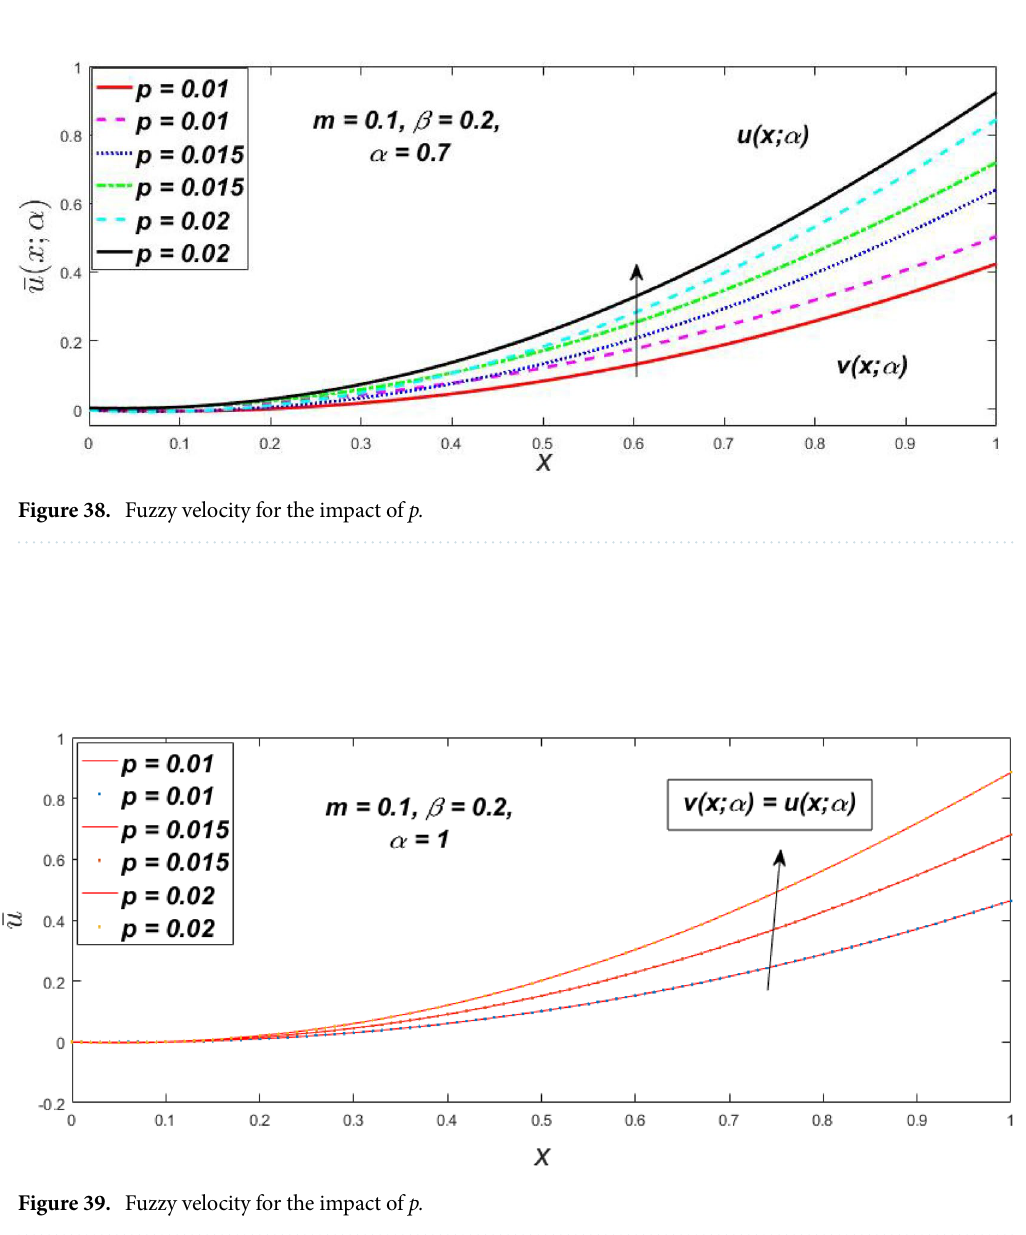
Figure 37. Fuzzy velocity for the impact of p.